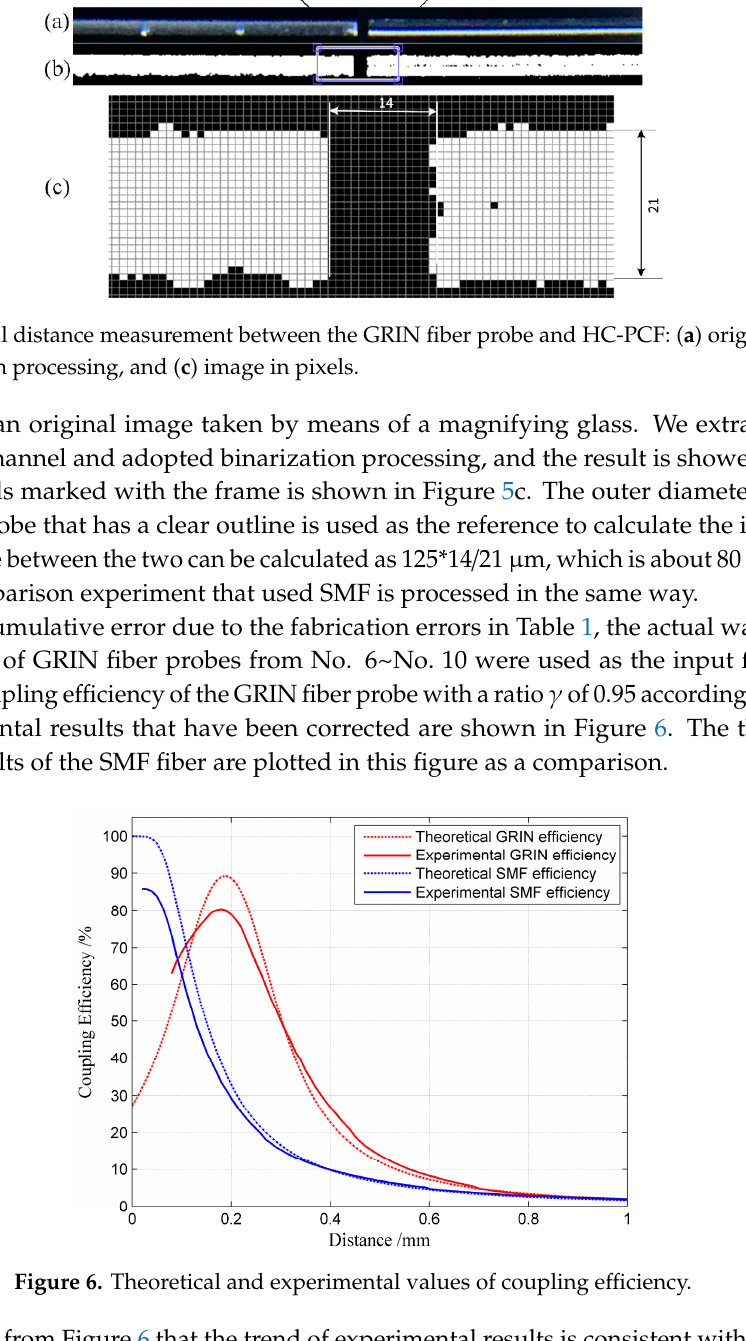
7 of 10 Figure 4. Coupling efficiency testing system: ( a ) Experimental system setup; ( b ) detail of coupling part. As shown in Figure 4a, the GRIN fiber probe connected to the ASE laser was mounted in the V- groove of the micro-displacement platform, and the emitted power p 0 was detected by the Beam Analyzer. After that, the GRIN fiber probe and HC-PCF were installed according to the assembled method in Figure 4b. The micro-displacement platform was adjusted to align two fibers until the